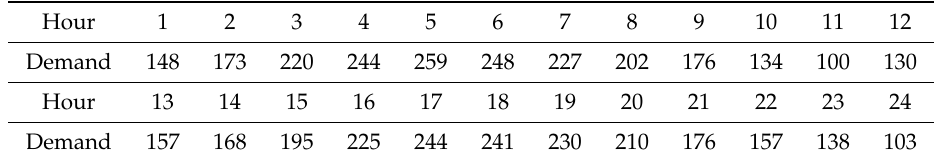
Table 5. 24-hour load demand for 5-unit system.